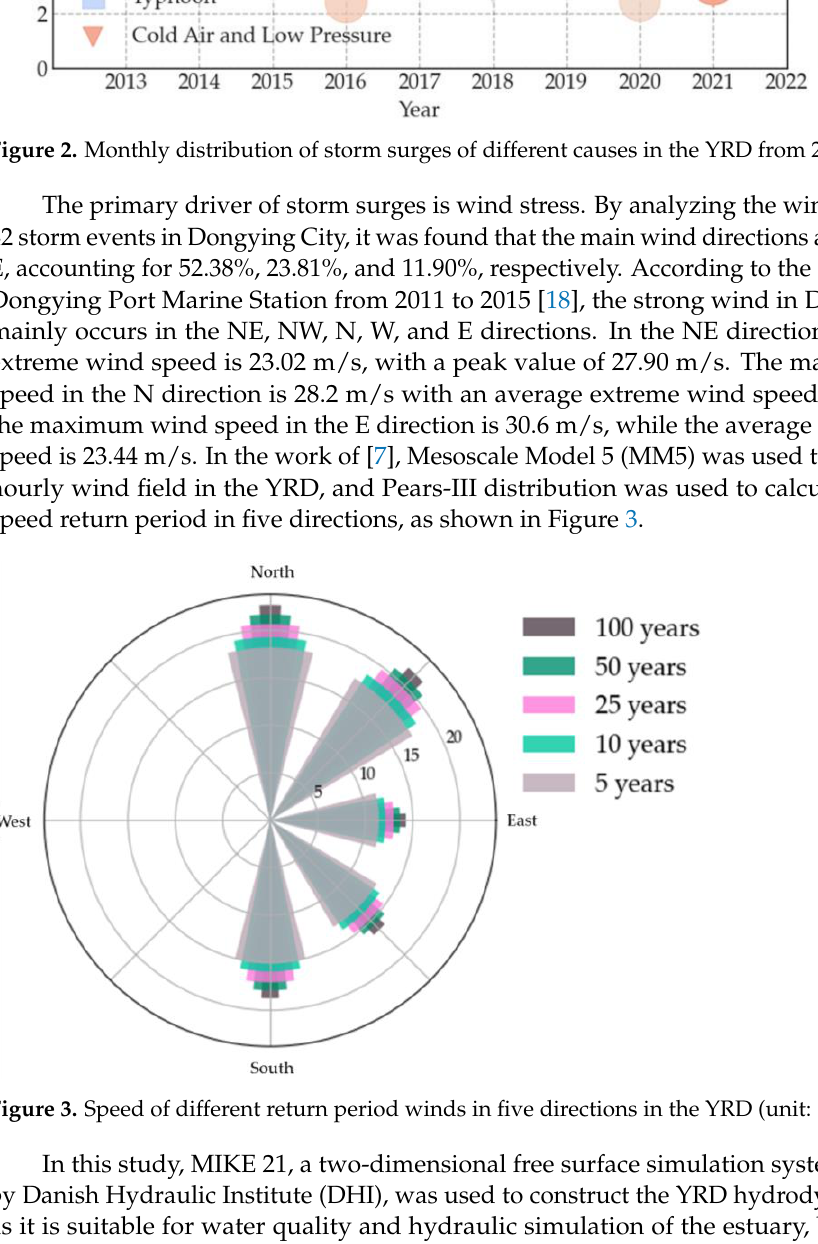
Figure 3. Speed of different return period winds in five directions in the YRD (unit: m/s). In this study, MIKE 21, a two-dimensional free surface simulation system developed by Danish Hydraulic Institute (DHI), was used to construct the YRD hydrodynamic model, as it is suitable for water quality and hydraulic simulation of the estuary, bay, lake, and other areas. The computational domain is discretized by the finite volume method, and the two-dimensional unsteady flow of vertically homogeneous fluid is simulated based on the time-averaged Navier–Stokes equations [19]. The simulation model covers the entire Bohai, the Yellow Sea, and the northern part of the East China Sea (Figure 4). The model mesh contains all the land in the YRD and is refined near the coastline, with a total